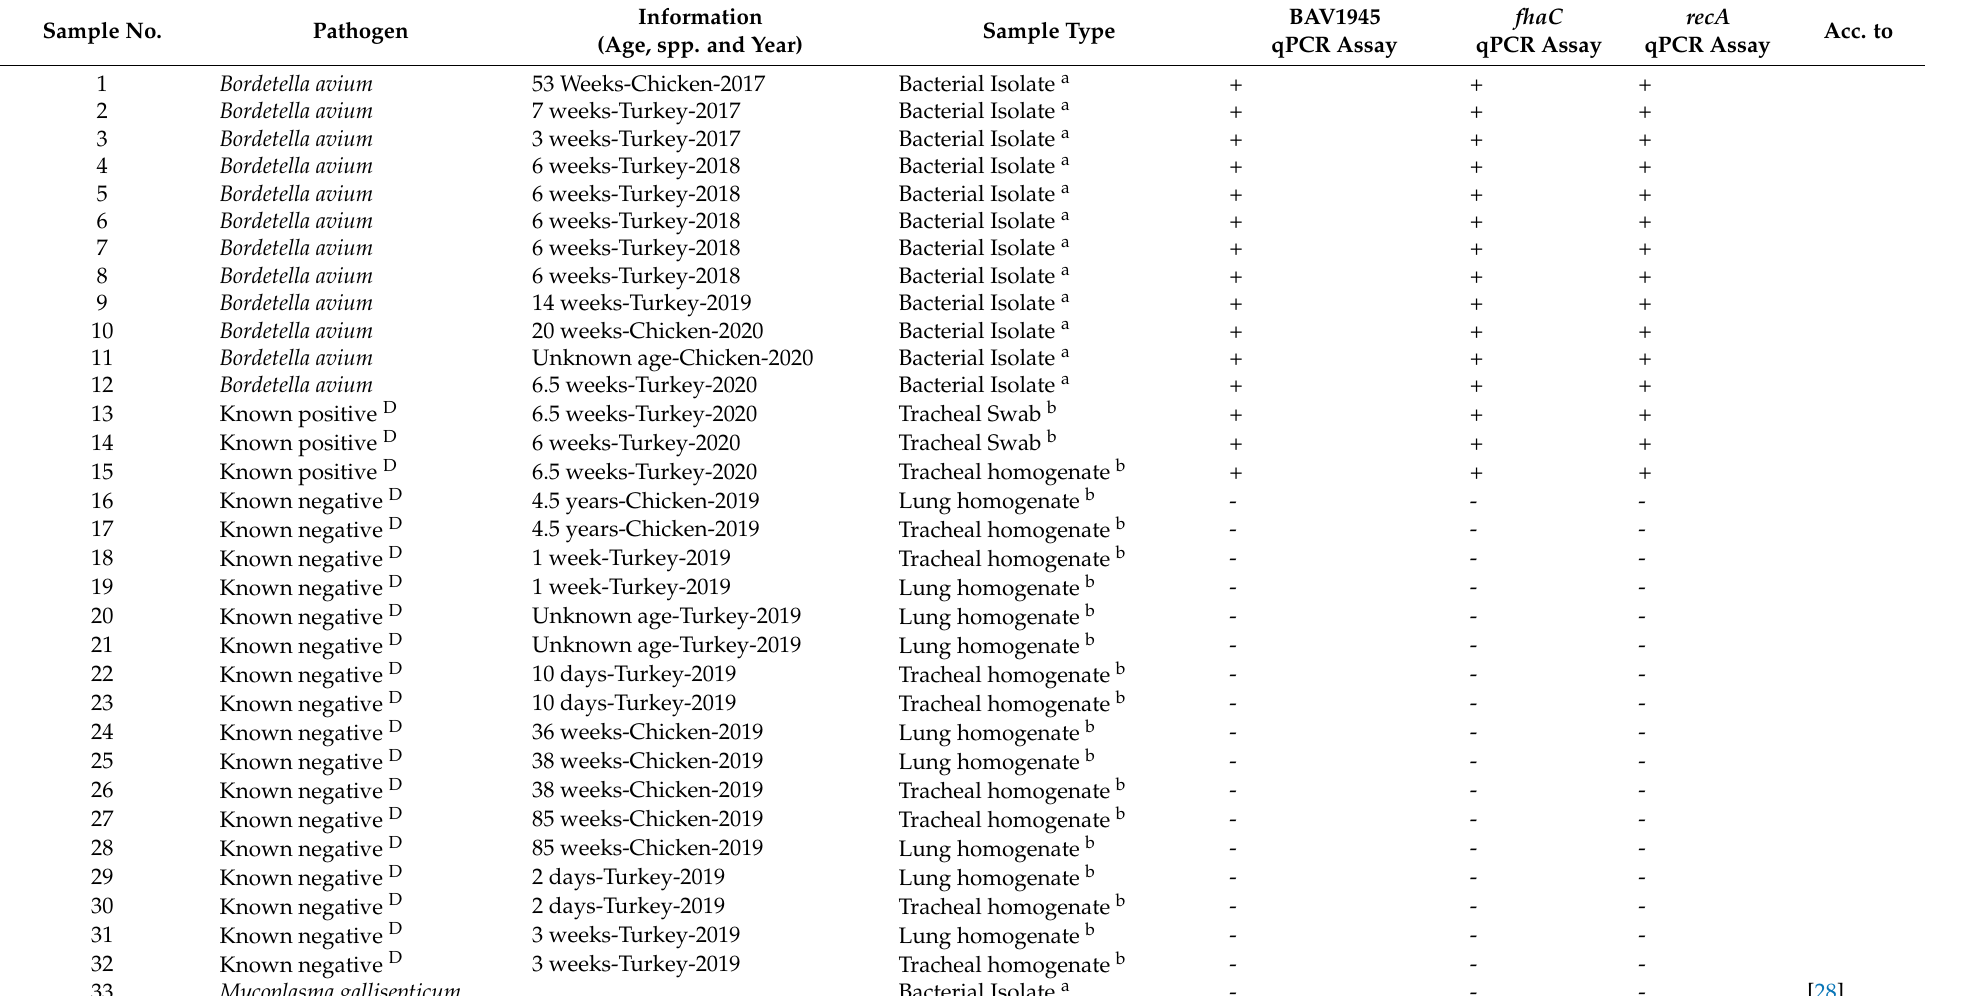
Table 3. Bordetella avium and other avian pathogens were used in this